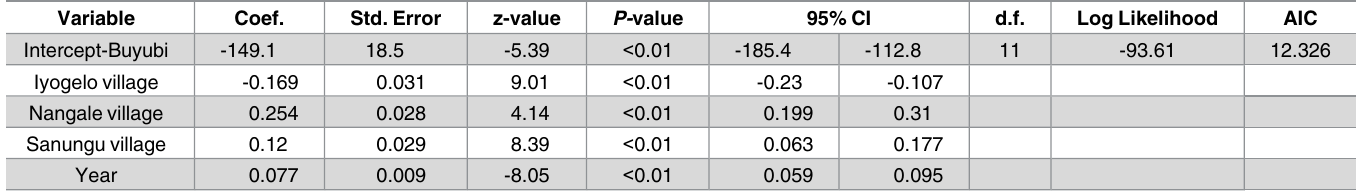
Table 4. Summarystatistics of GLM best model assessing effectsof village and year on the total number of dogs. Variable Coef. Std. Error z-value P- value 95% CI d.f. Log Likelihood